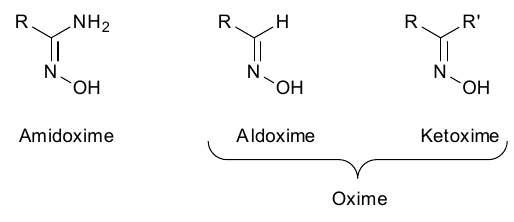
Figure 1. Structures of amidoximes and oximes.